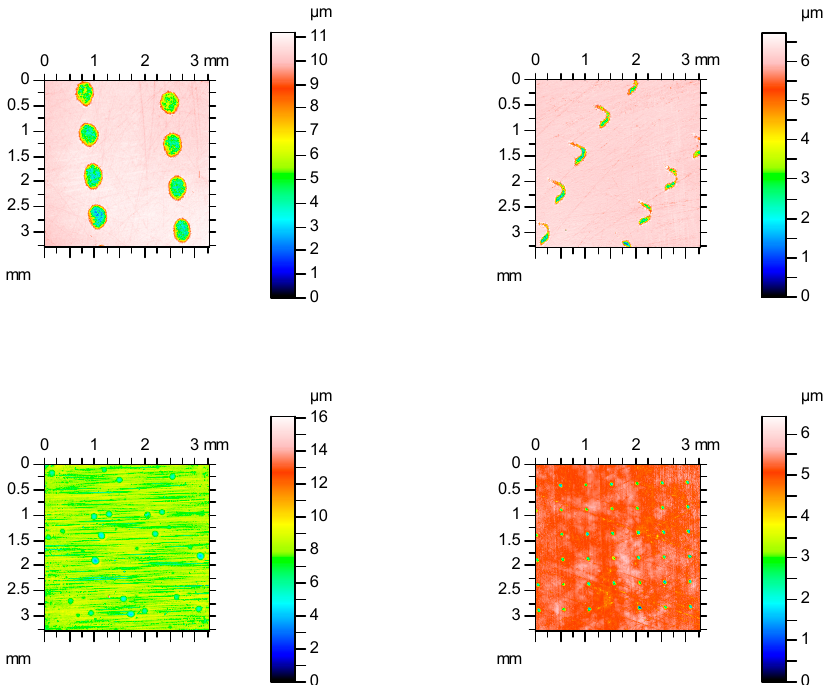
Figure 7. Contour plots of the surfaces containing isolated oil pockets.